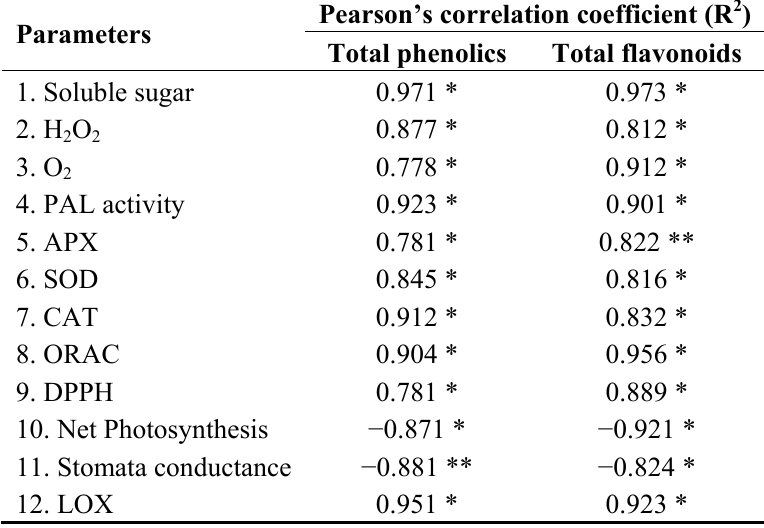
Table 2. Pearson’s correlation coefficients between total phenolics and total flavonoids with all parameters measured in the